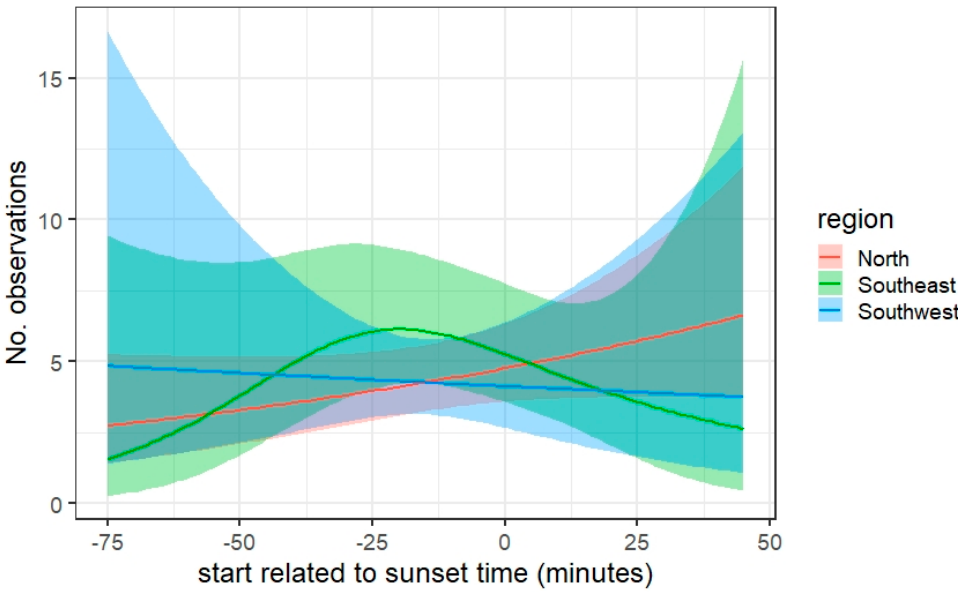
Figure 5. Effect of starting time on the number of observations along a transect walk given for three regions. Model outcome is plotted as a line with the confidential interval as a ribbon, after taking into account the effect of the other variables in the model.